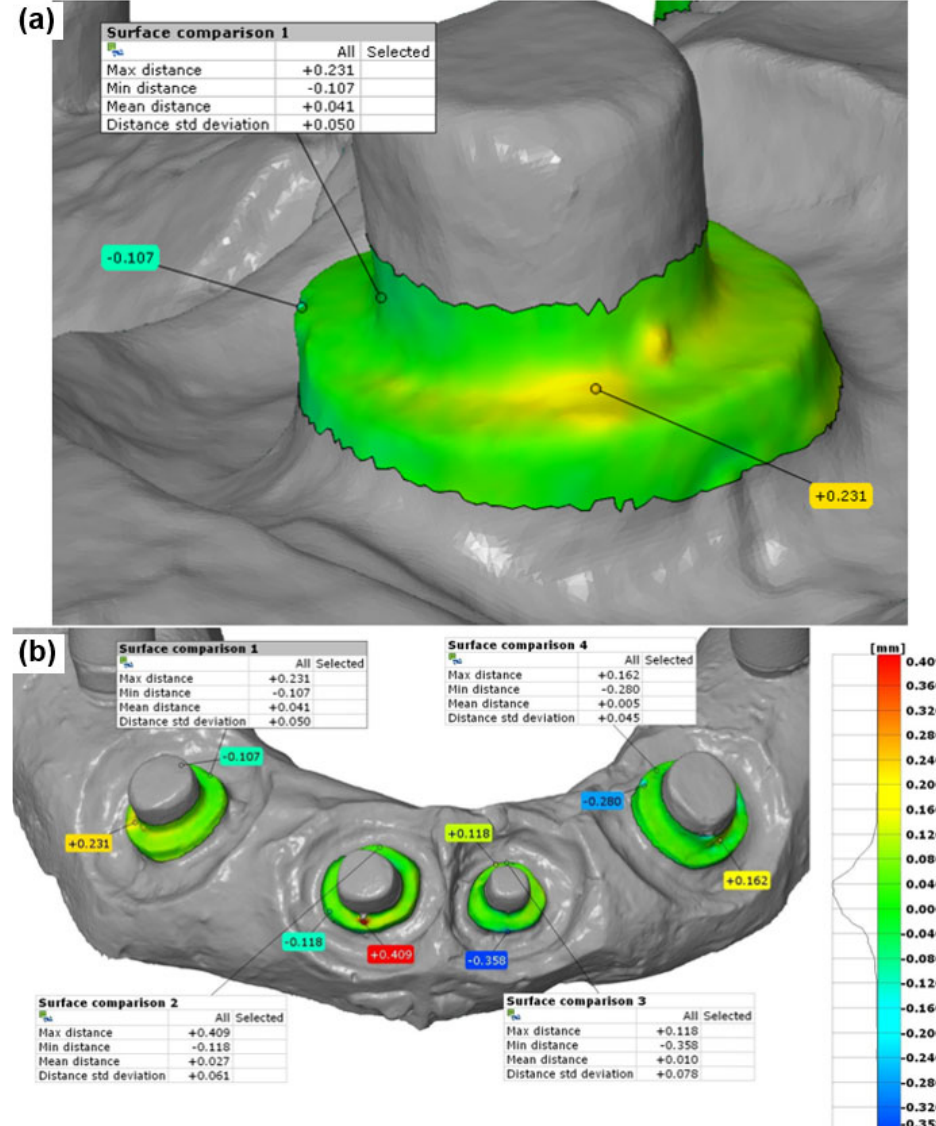
Figure 13. Showing ( a ) CAD inspection analysis of the selected area on one tooth and ( b ) analysis of all teeth (T1–T4).